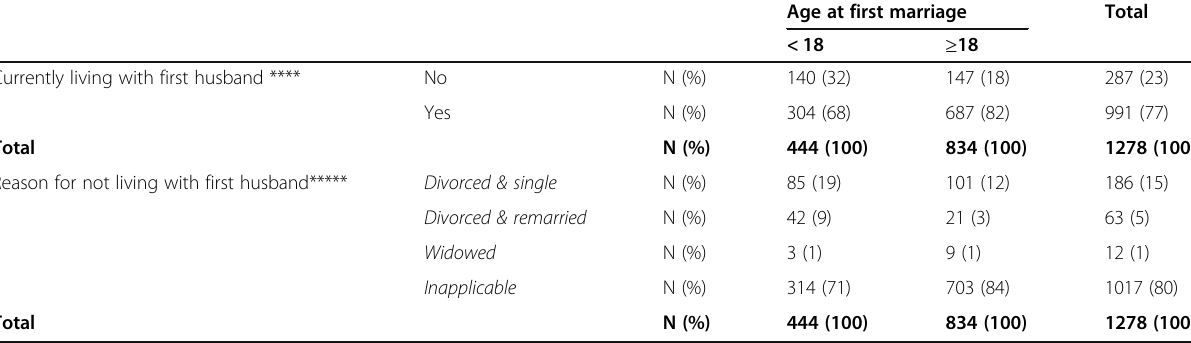
Table 1 Current living arrangement with first husband by age at first